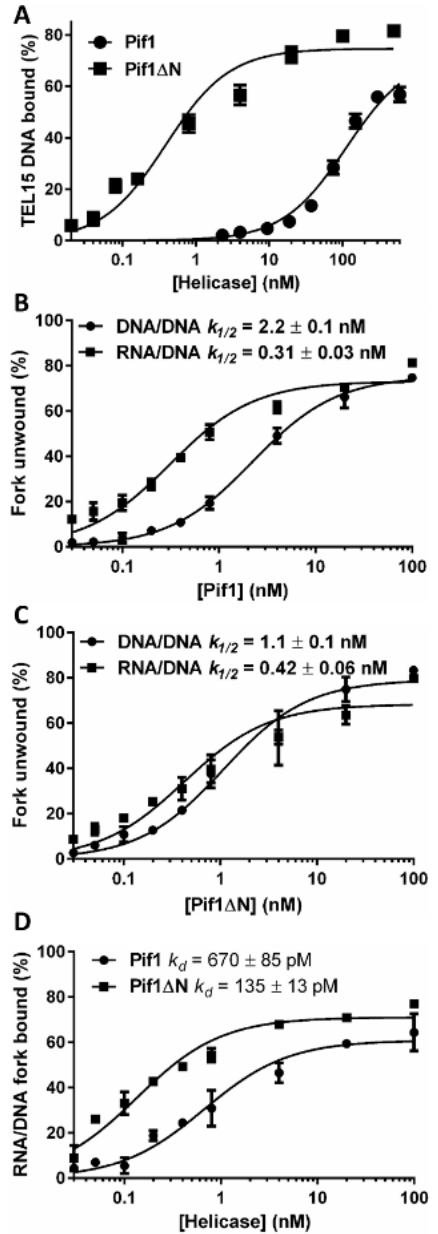
Figure 5. The NTD of Pif1 a ff ects DNA binding and helicase activities. ( A ) Pif1 ∆ N binds the Tel15 single-stranded DNA (ssDNA) substrate much more tightly than full-length Pif1. The plotted values represent the results of EMSAs using radiolabeled Tel15 and the indicated concentrations of Pif1 and Pif1 ∆ N protein. ( B ) Pif1 helicase activity is stimulated by RNA–DNA hybrids. Unwinding of a radiolabeled DNA–DNA fork substrate and an analogous RNA–DNA fork were monitored with native gels at the indicated concentrations of Pif1. ( C ) Pif1 ∆ N displays minor helicase activity stimulation in the presence of the RNA–DNA hybrid fork. ( D ) Both Pif1 and Pif1 ∆ N have higher a ffi nity for the RNA–DNA hybrid fork substrate the than Tel15 ssDNA. All data points represent the average of ≥ 3 independent experiments, and the error bars correspond to the standard deviation. The plotted data were fit with hyperbolic curves using GraphPad Prism